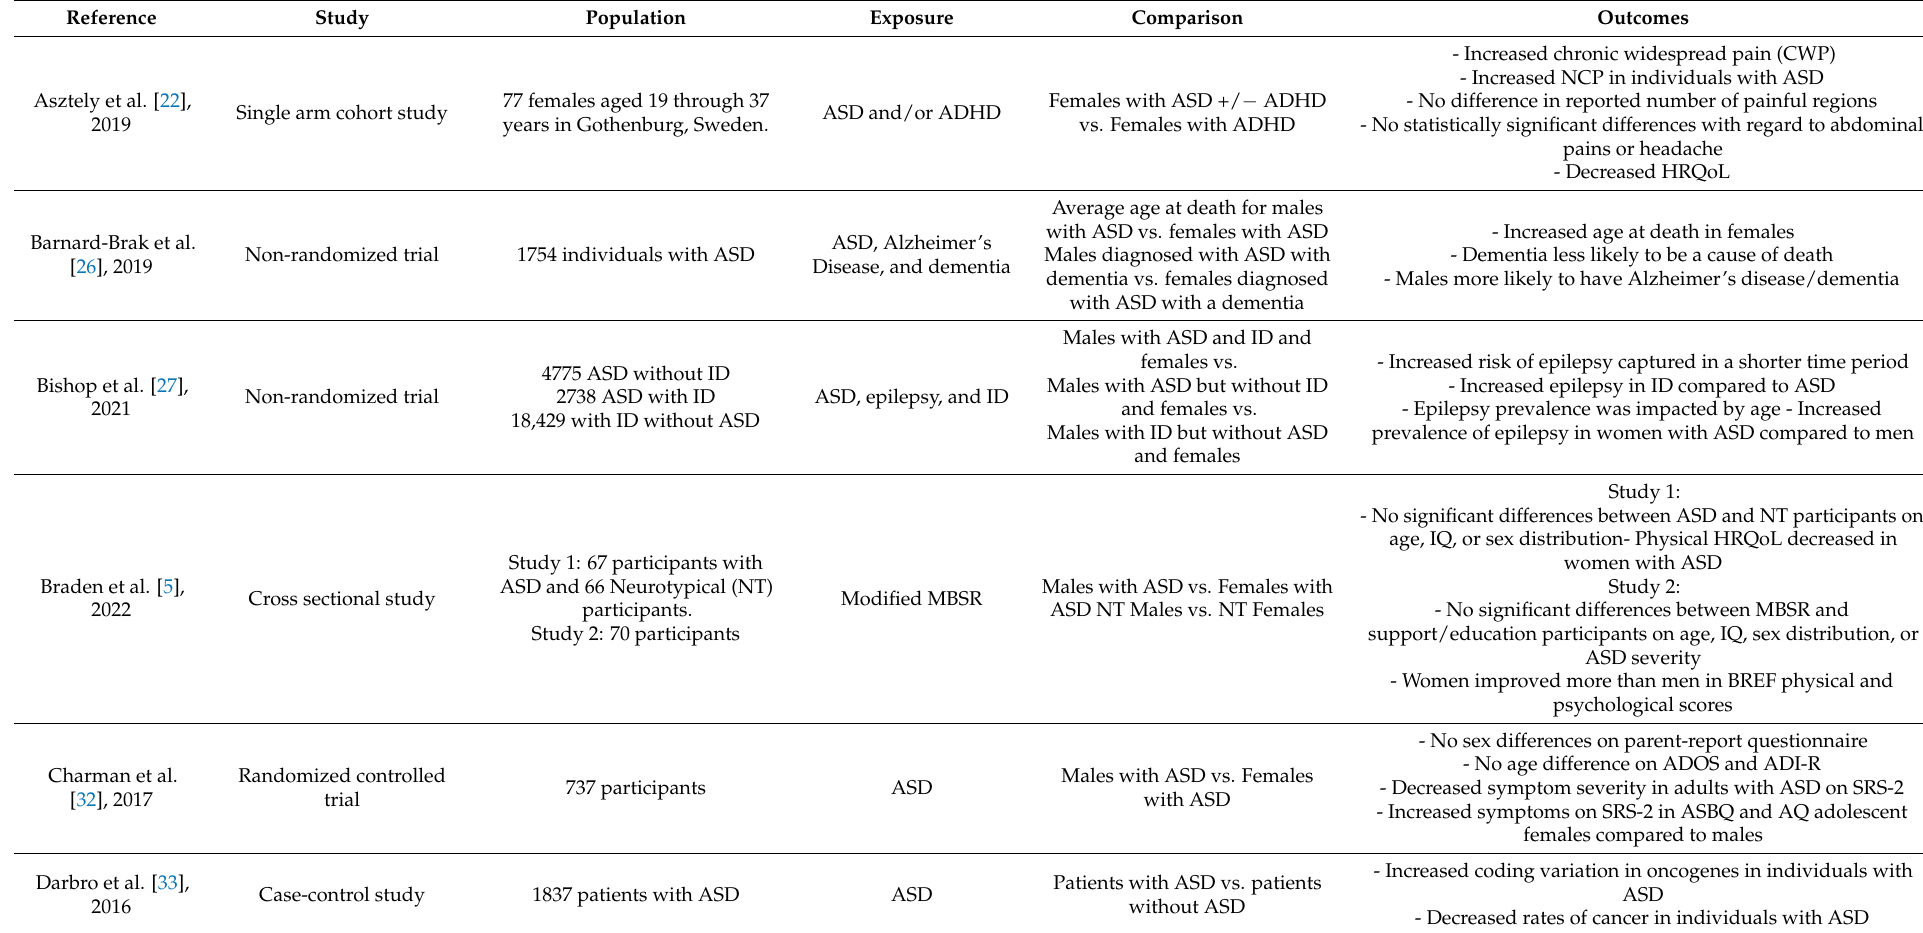
Table 2. A summary of main findings of included